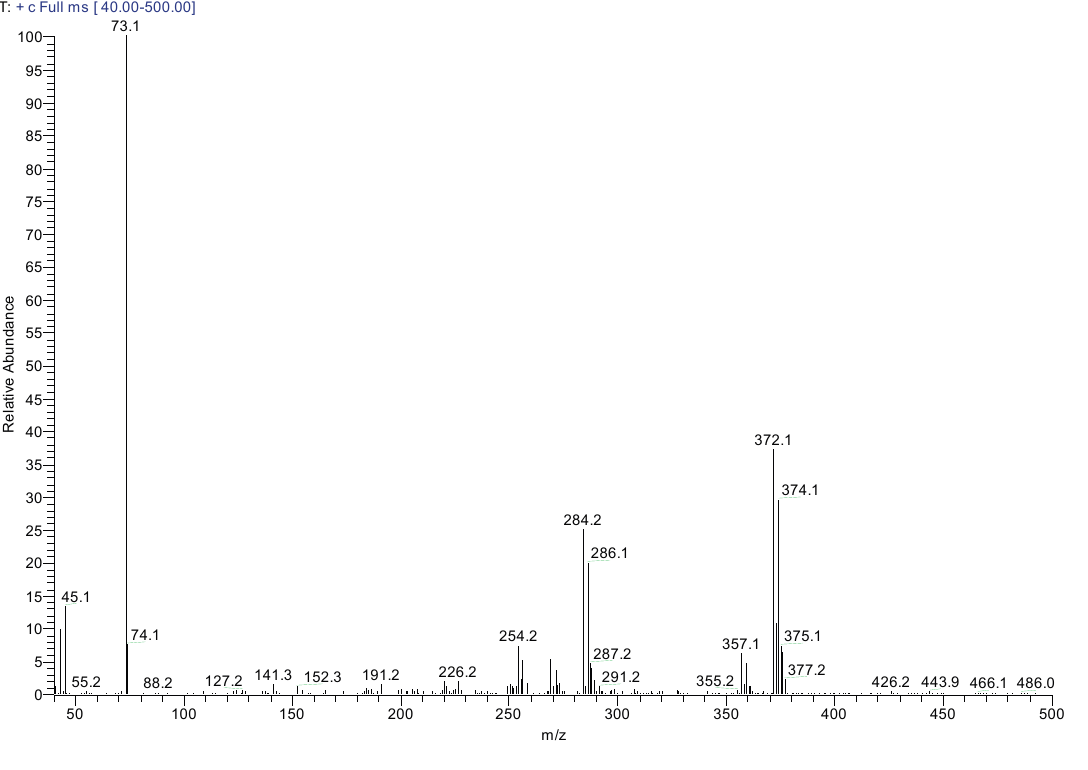
Figure 12. MS spectrum of a silane-derivatized sample at peak 26.4